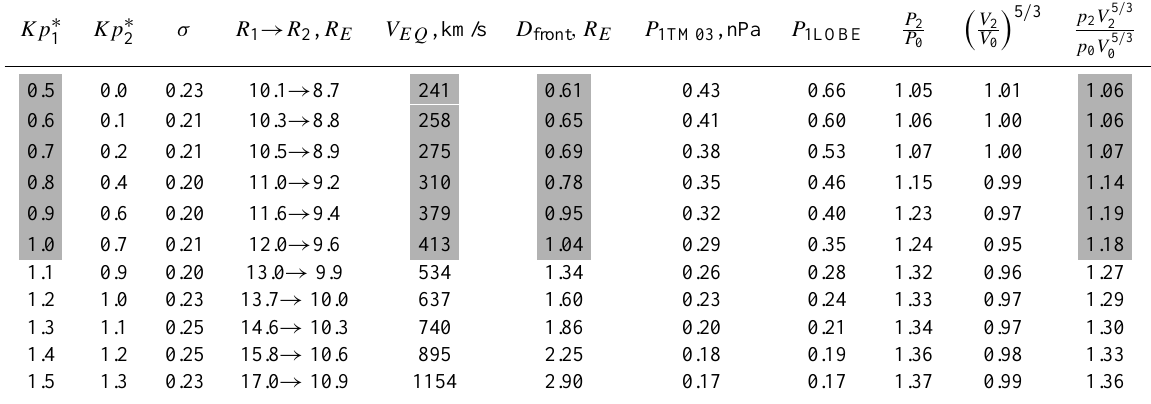
Table 1. Different K ∗ p pairs, standard deviation, injection front observed at C1 and C4 mapped to the equatorial plane, front propagation speed, front thickness, initial pressure obtained from Tsyganenko and Mukai (2003) and vertical pressure balance. The injected flux tube parameters (pressure, volume, entropy) related to those in the neigbouring flux